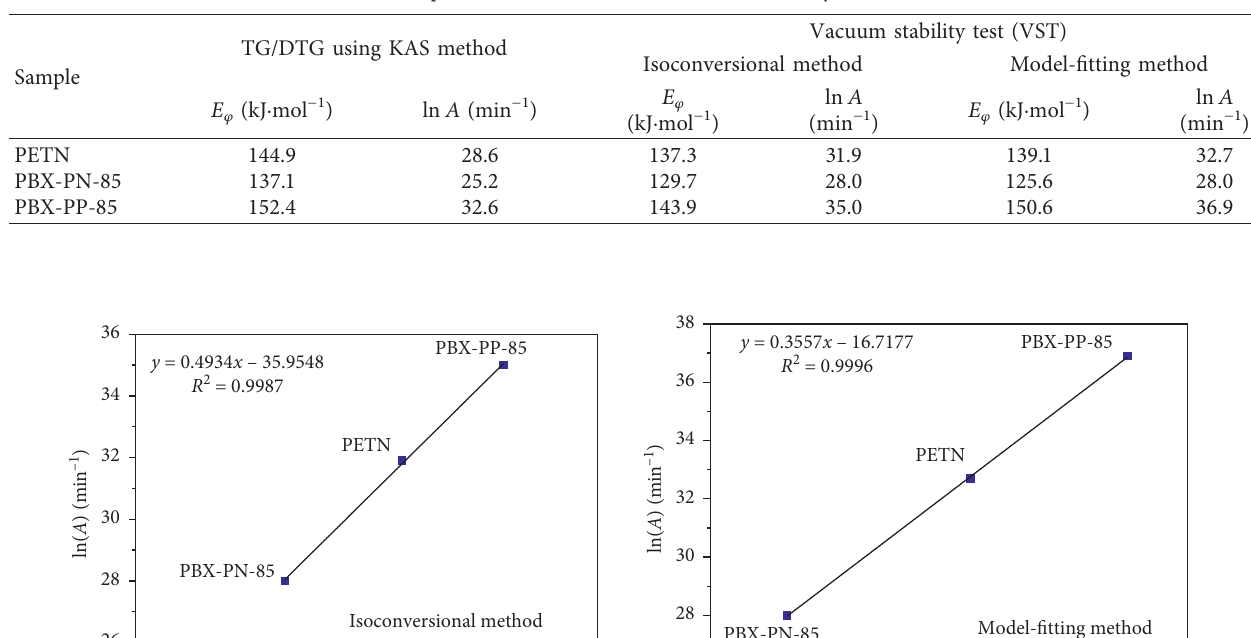
A of all samples obtained from the VST φ with ln